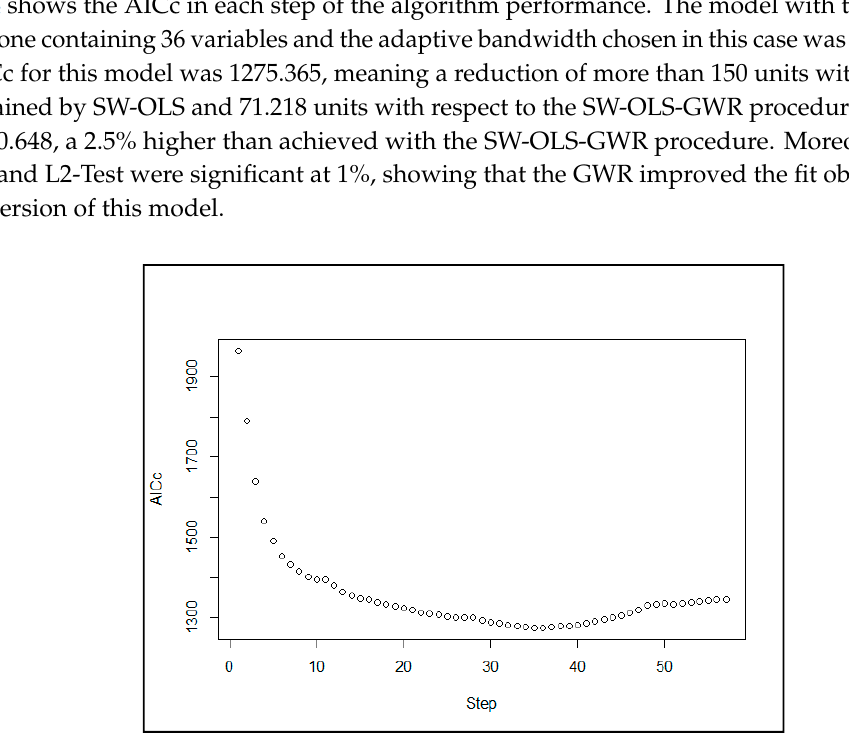
Figure 4. Evolution of the AICc along the Pre-SW-GWR algorithm.